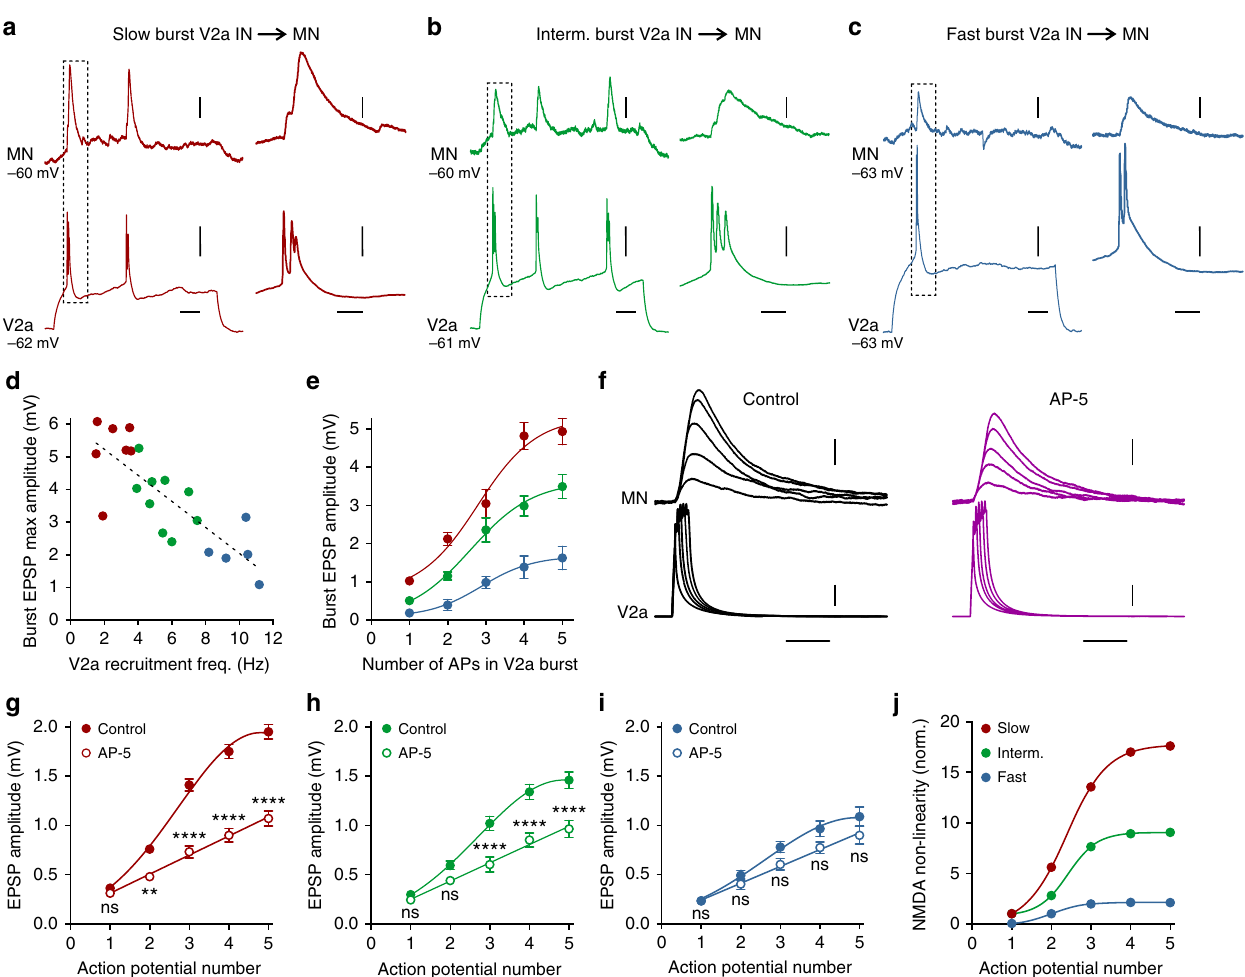
Fig. 4 NMDA-dependent short-term potentiation of bursting-type V2a interneuron synaptic transmission. a – c Single bursts of action potentials in V2a interneurons of the slow, intermediate and fast modules produced a large monosynaptic EPSPs in the target motoneurons. d The maximum amplitude of the burst-induced EPSPs was graded according to the order of recruitment of the V2a interneurons during swimming. Each point in the graph re fl ects a single measurement from different V2a interneuron-motoneuron pairs. e The EPSPs elicited by bursting V2a interneurons showed a strong non-linear summation as a function of the number of action potentials in a burst. The magnitude of the short-term potentiation produced by the bursting-type V2a interneurons conformed to their modular identity ( n = 6 pairs of slow module; n = 6 pairs of intermediate module; and n = 6 of fast module; error bars in the graph re fl ect the s.e.m.). f A similar non-linear summation was produced by current injections into the bursting-type V2a interneurons that mimicked a normal burst with increasing number of action potentials. The short-term potentiation was blocked by the NMDA receptor antagonist AP-5. g – i Summary of the results of experiments shown in f . Blockade of NMDA receptors switched the integration mode from non-linear to linear summation ( n = 6 pairs of each module; error bars in the graph re fl ect the s.e.m.; interaction slow: F 4,50 = 26.20, P < 0.0001; intermediate: F 4,50 = 6.14, P = 0.0004; fast: F 4,50 = 0.99, P = 0.4197; two-way repeated-measures ANOVA: **** P < 0.0001; *** P < 0.001; ** P < 0.01). j The magnitude of the NMDA-mediated nonlinearity was largest in the slow module and lowest in the fast module. Data in this graph were obtained by subtracting the mean EPSP amplitude in AP-5 from control. Scale bars, 50 m, 10 ms, 10 mV, 1 mV a – c , 20 ms, 10 mV, 0.4 mv f